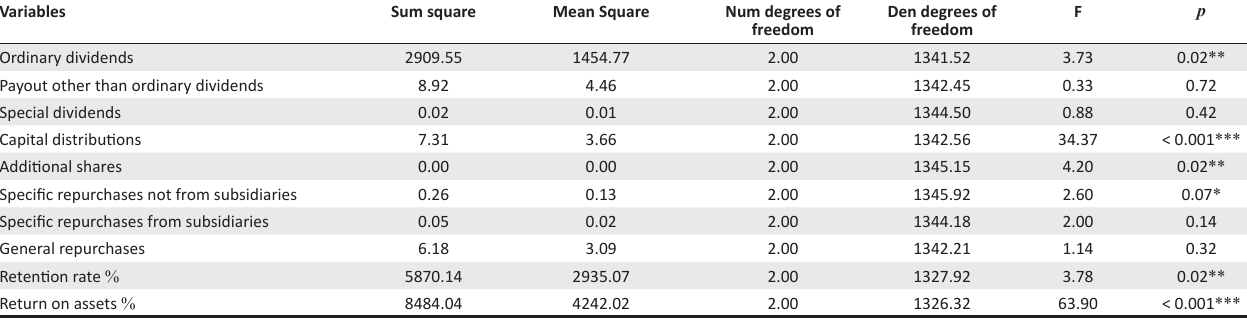
TABLE 4: Analysis of variance of payout methods and financial ratios. Variables